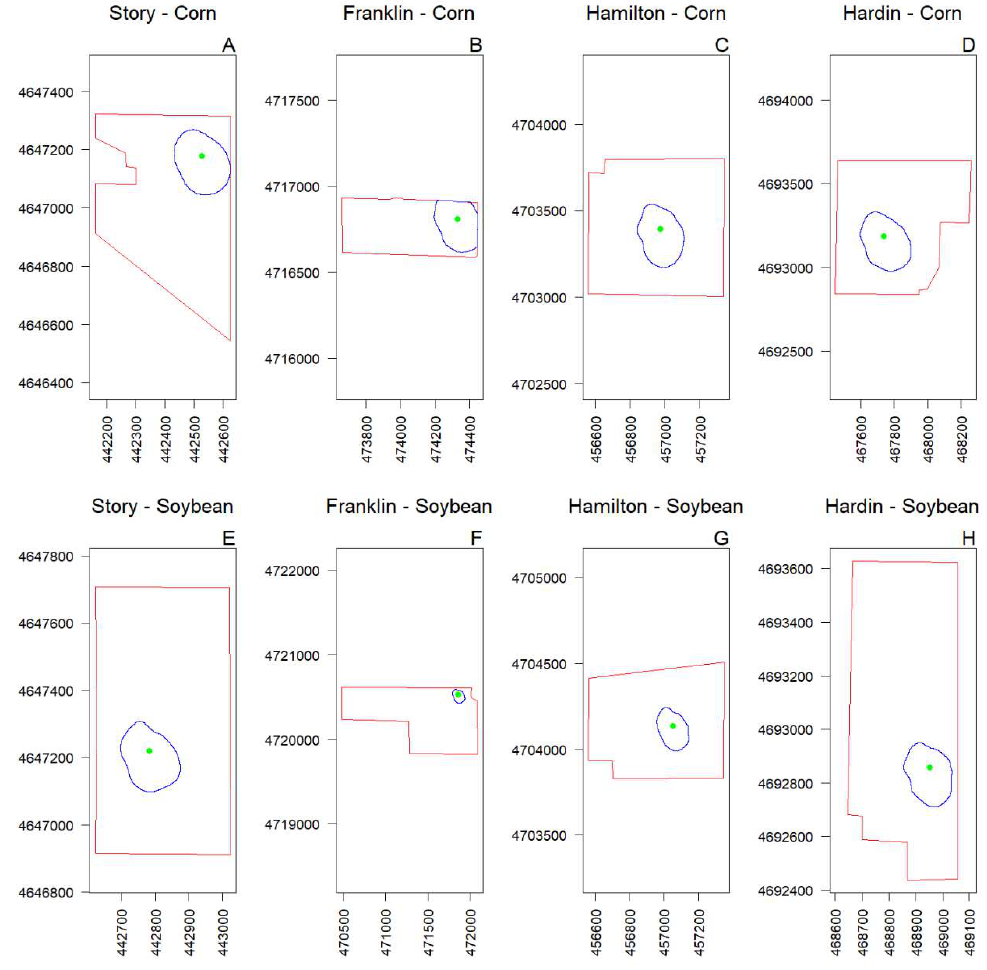
Figure A1. The average 90% flux footprint area (blue borders) of each EC station (green circles) within corn ( A – D ) and soybean ( E – H ) fields (red borders) in Story, Franklin, Hamilton, and Hardin County, Iowa.